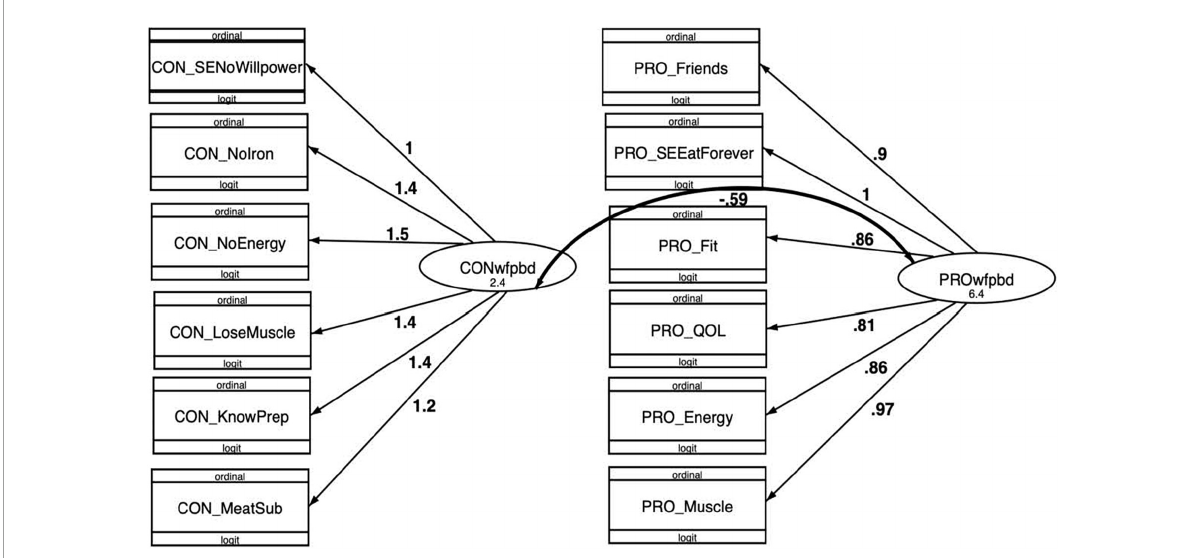
FIGURE1 Final (12-item) generalized logit confirmatory factor analysis (CFA) model for WFPBD Survey, with factor loadings and covariances.